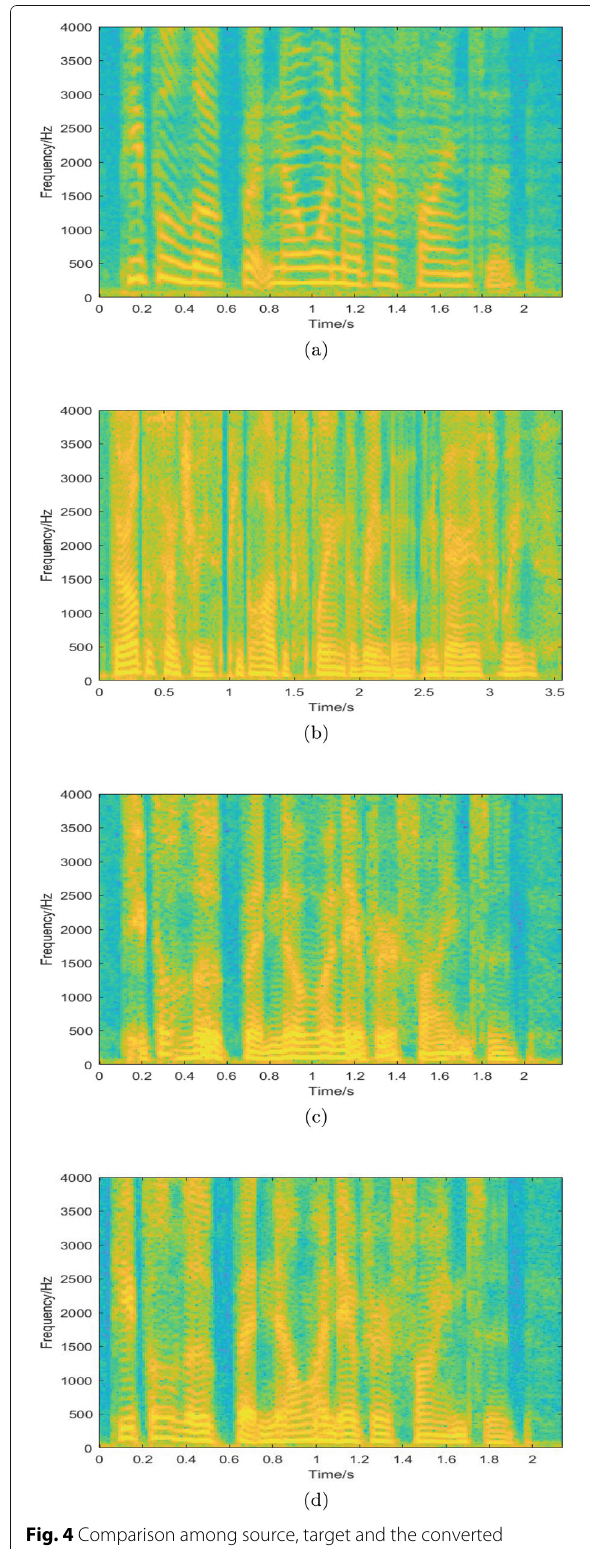
Fig. 4 Comparison among source, target and the converted spectrograms. a Source speech. b Target speech. c The converted speech of AGAIN-VC. d The converted speech of U 2